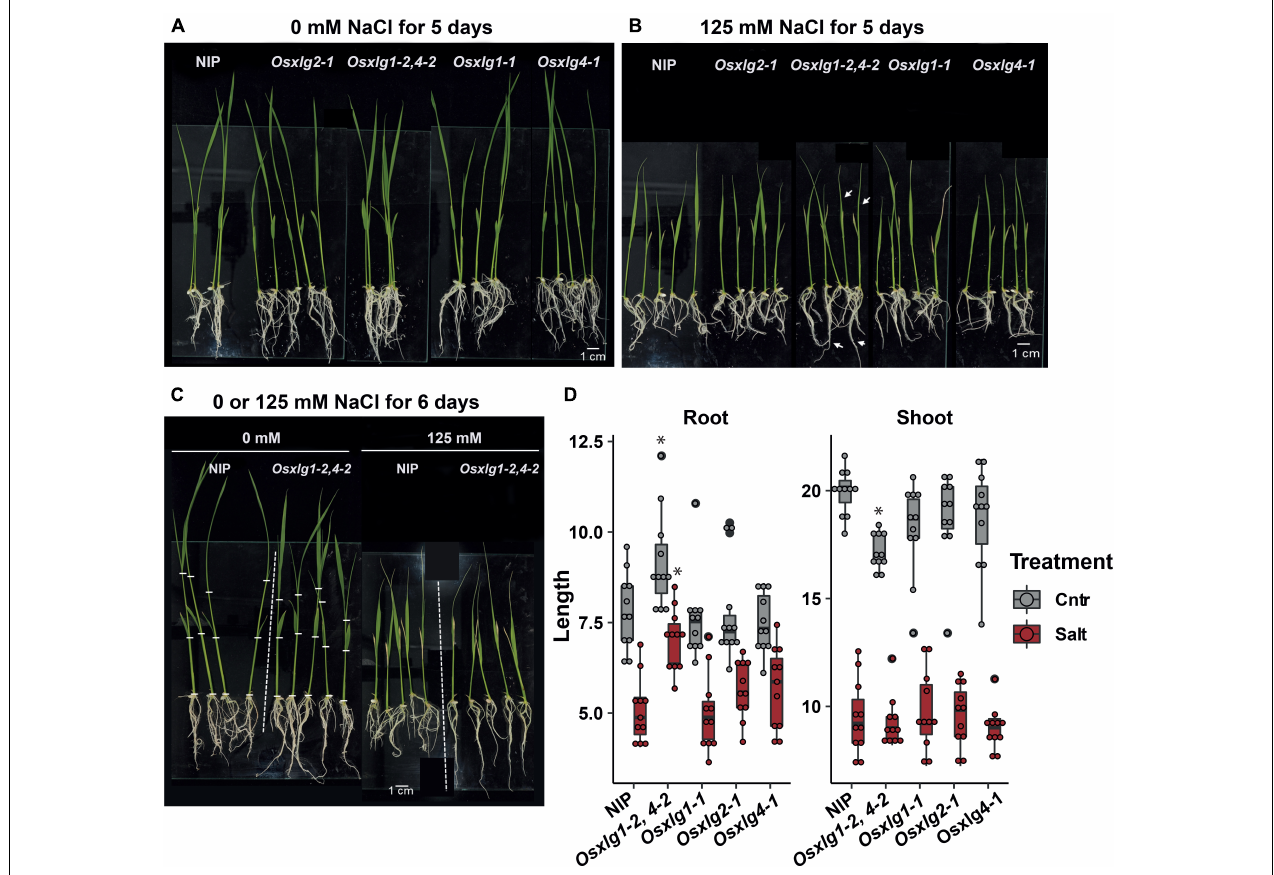
FIGURE 6 | Root and shoot length of Osxlg mutants under salt stress condition. Seven-day-old hydroponically-grown rice seedlings were treated with 0 mM (Control, gray box) (A) , or 125 mM (Salt, red box) (B) , NaCl for 6 days (C) with root and shoot length (D) . Sample size = 10. Box plots show 1st and 3rd quantile. Significant differences were determined with two-way ANOVA followed by Tukey’s post hoc test. Different lowercase letters (a–d) indicate significant differences across